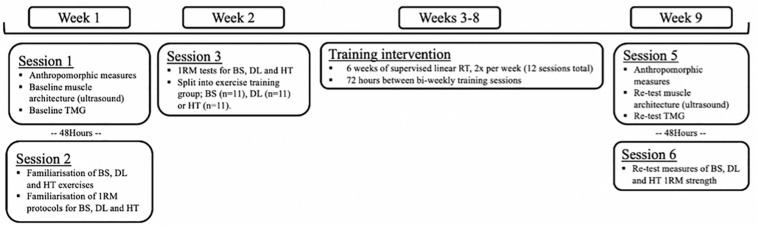
Schematic timeline of experimental design. TMG, tensiomyography; BS, back squat; DL, deadlift; HT, hip thrust; 1RM, one maximal repetition; RT, resistance training.